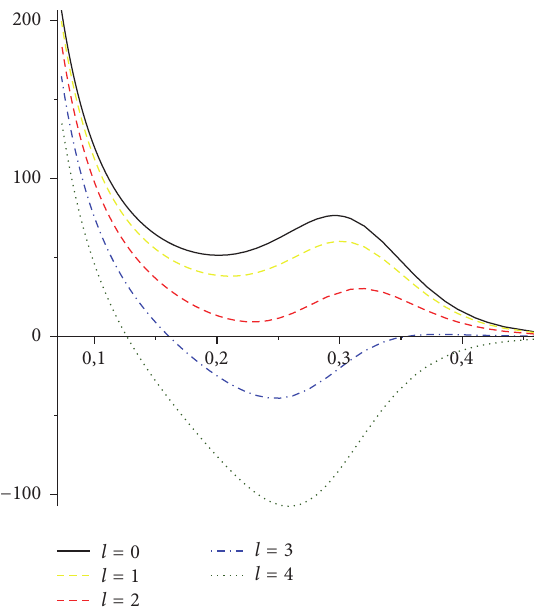
Figure 6: The potential 𝑉 in function of the tortoise coordinates for the fixed values of 𝛼 0 = 0.677 , 𝑀 = 1 , and 𝜇 = 0.1𝑀 .